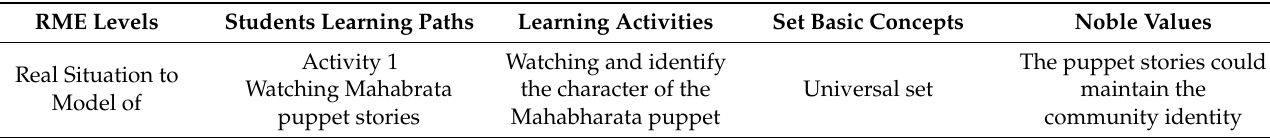
Table 1. The learning activities using the Indonesian shadow